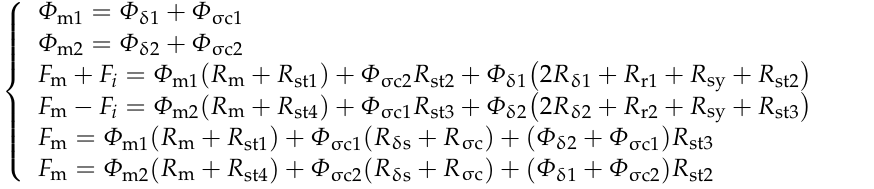
Figure 2. Operation principle of TF-CFRM.